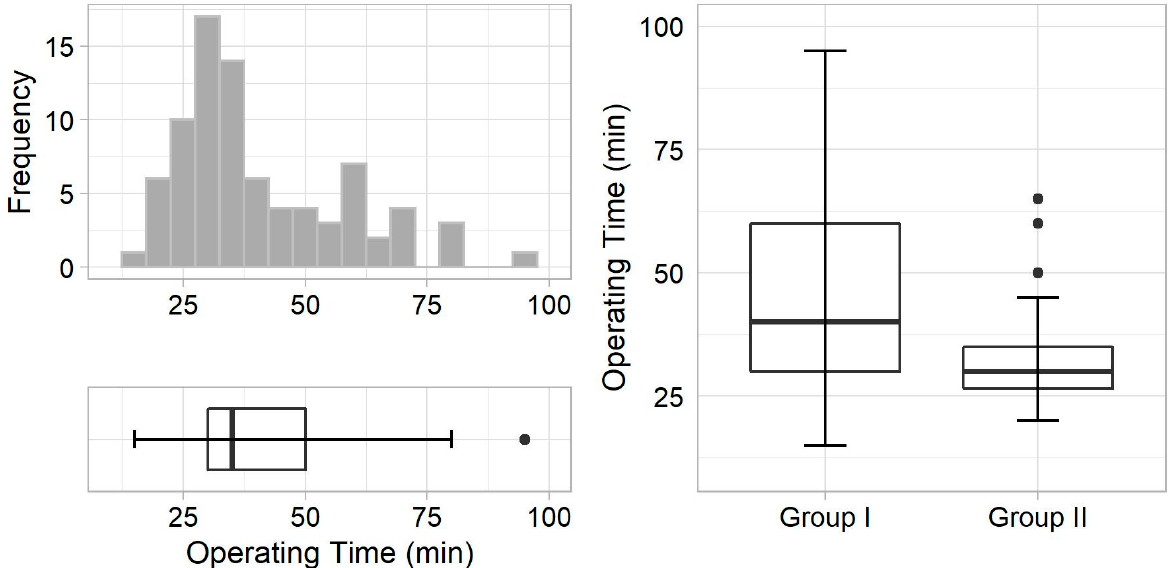
Figure 2. Visualisation of the recommended time span for surgery from radionuclide administration in every patient in group II.